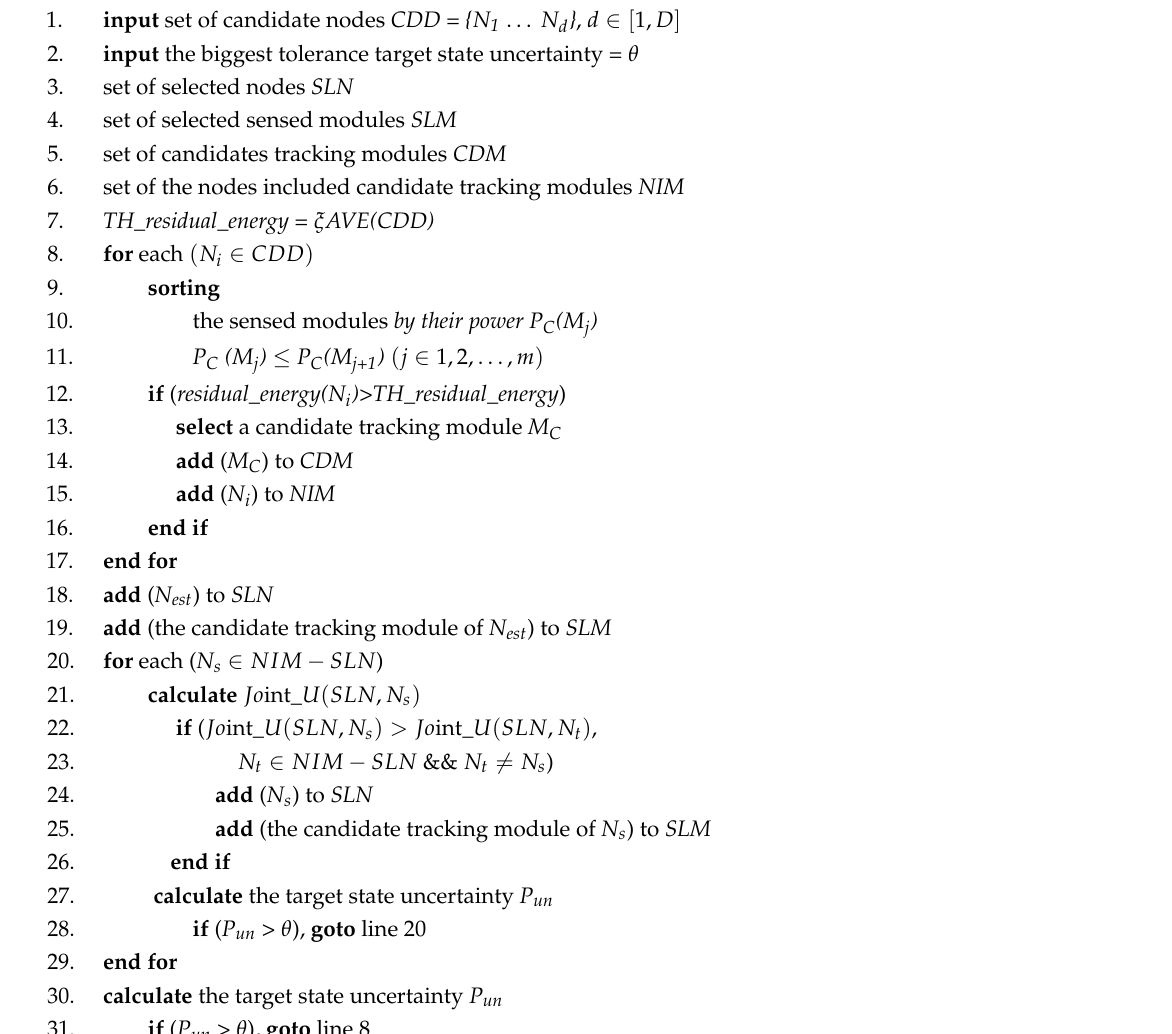
Algorithm 2. Adaptive nodes and sensed modules selection in tracking